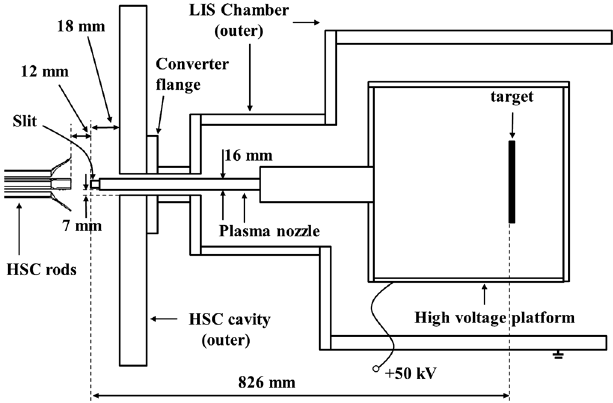
FIG. 9. The injection system for the HSC linac.